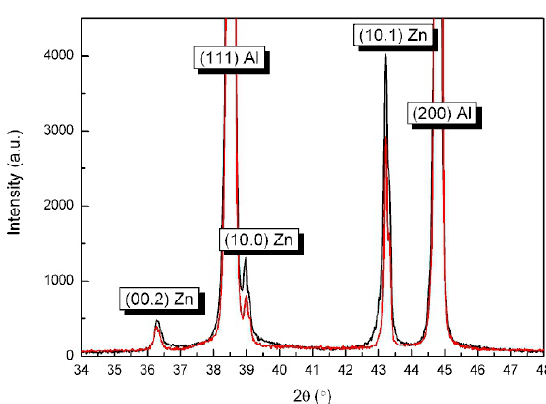
Fig. A2. XRD profiles of the Al-30Zn alloy after ECAP (black line) and after ECAP+SA (red